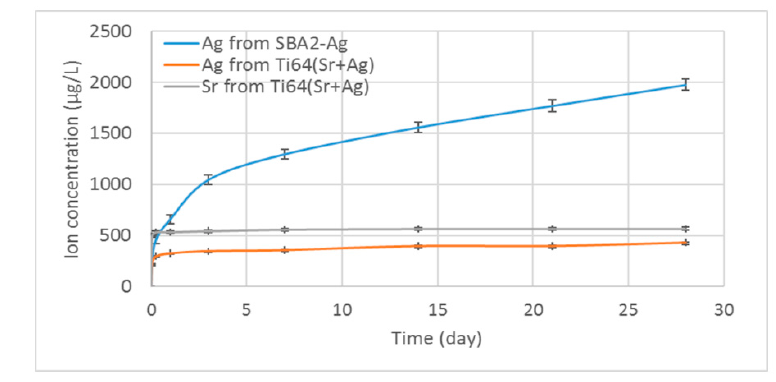
Figure 4. Ion release of Ti64(Sr+Ag) and SBA2-Ag in fetal bovine serum (FBS) during 28 days of soaking.